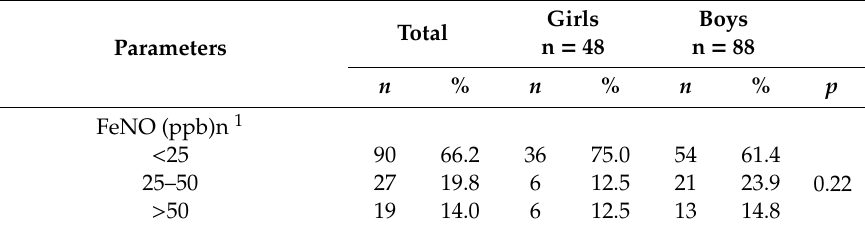
Table 5. FeNO, hired Latinx child farmworkers in North Carolina (n =